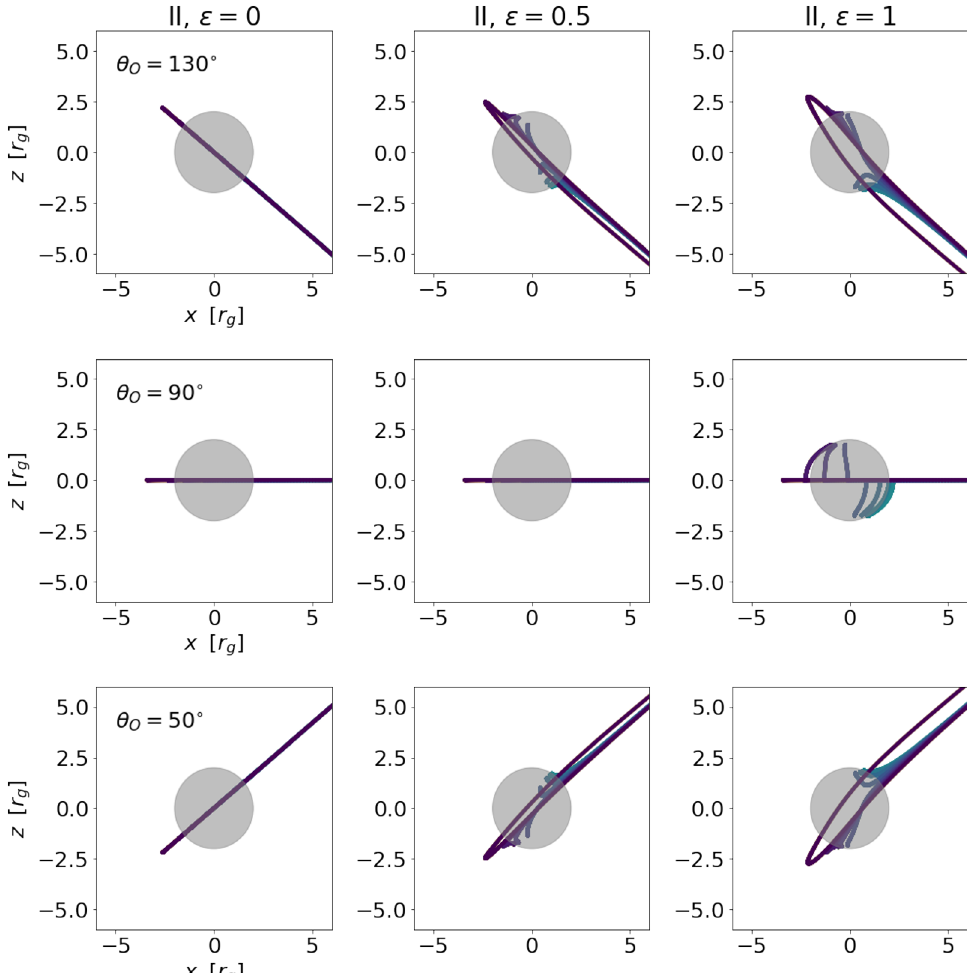
Figure 9 . Edge-on view of geodesics for different observer’s inclination angle and different size parameter E for type II perturbation. When E = 0 (Schwarzschild case), the geodesics are coplanar. As E increases, the geodesics is no longer coplanar due to the nonzero g rθ term, resulting in the shift of center of the shadow. The geodesics shown in this figure contribute to the computed shadow image along the β = 0 plane. The right column ( E = 1 ) corresponds to cases (d), (e), (f) in figure 8, respectively. The case ( θ O = 130 ◦ ) shown in figure 5 is identical to the case shown in the first